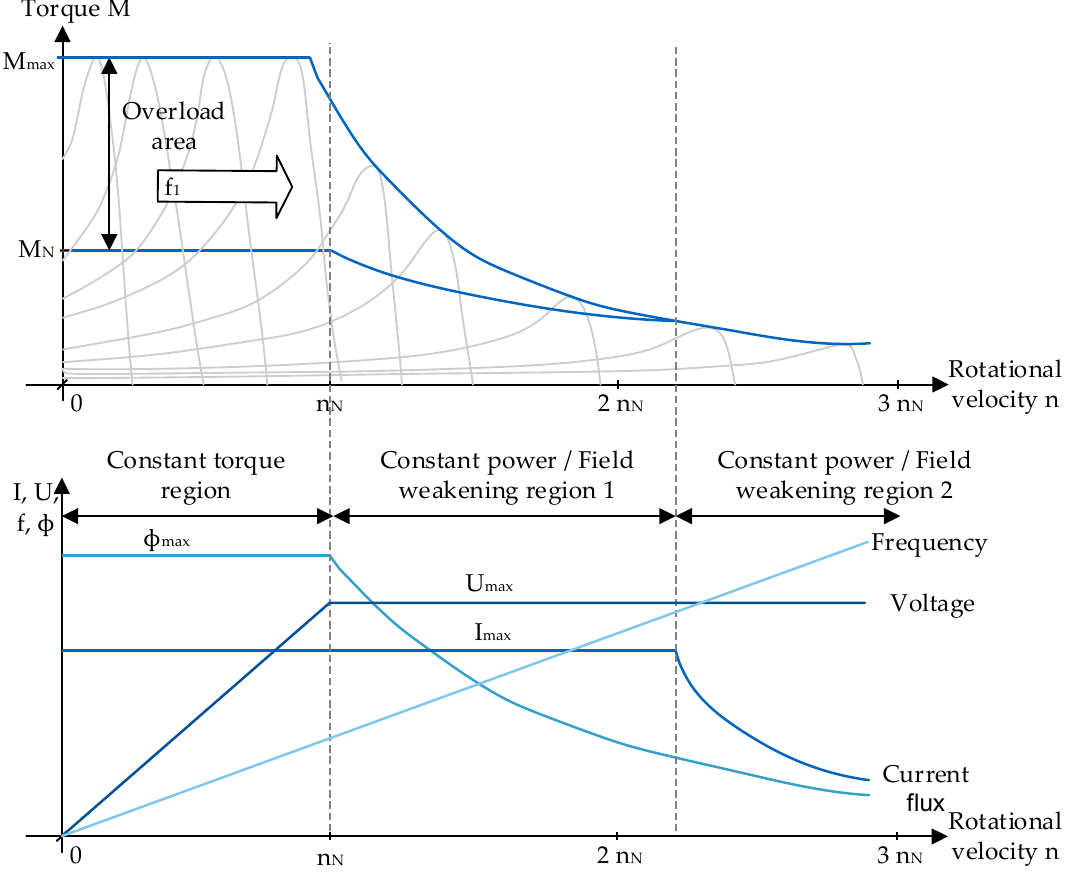
Figure 1. Speed-torque characteristic diagram of an IM with variable speed operation [15,20].